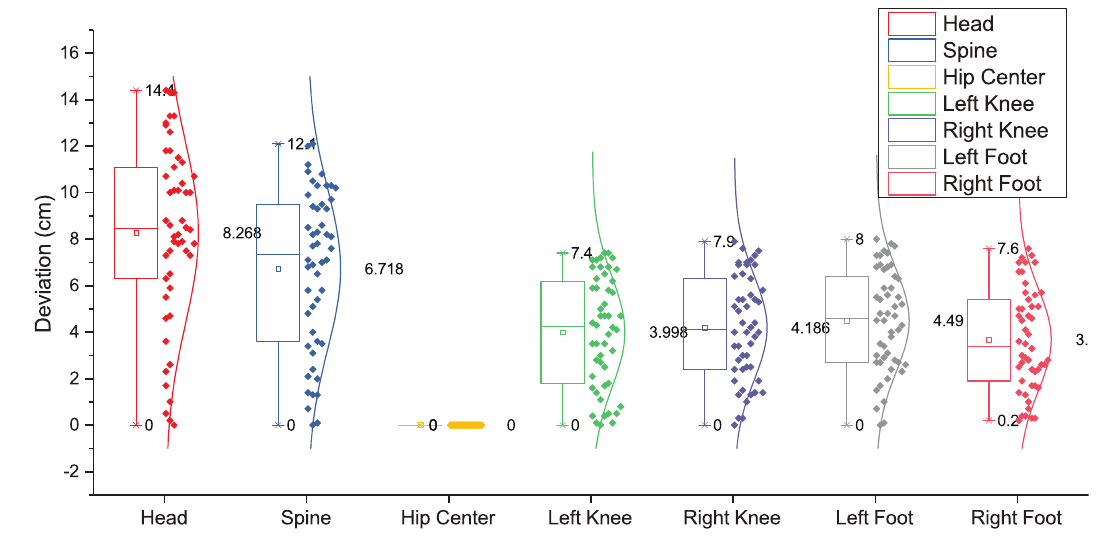
Figure 7. Deviation between SSSE-extracted joints and ground